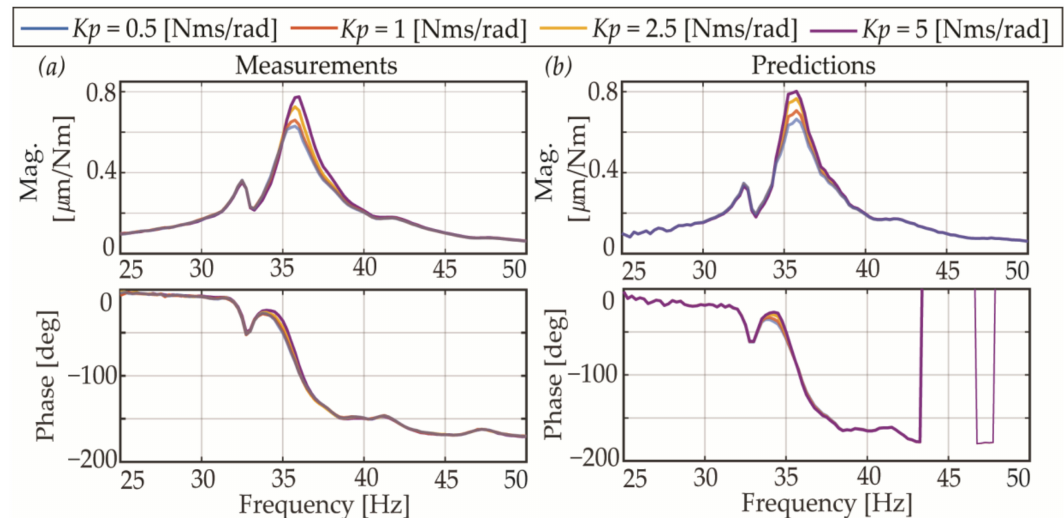
Figure 11. ( a ) Experimental; ( b ) Predicted closed-loop tool centre point dynamics.